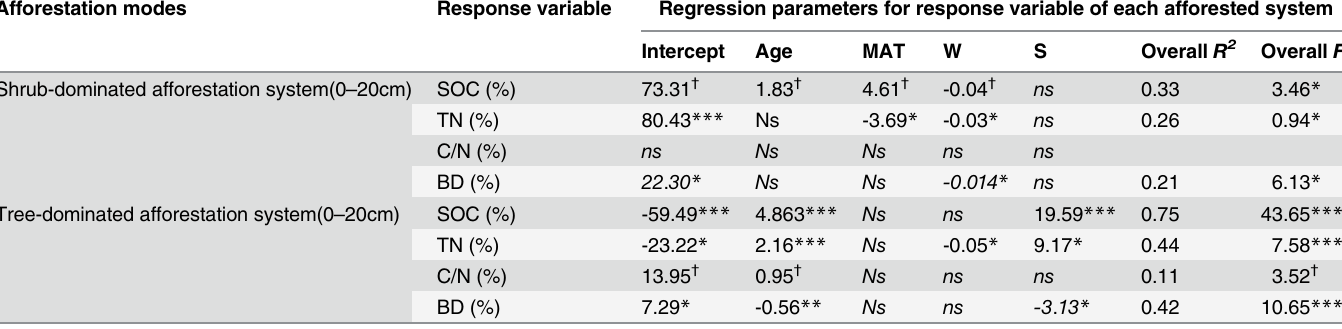
Table 2. Multiple regression models for each response variable in each afforested system was established on the plantation age (Age), mean annual temperature (MAT), mean annual availability water (W) and the number of plant species (S). Afforestation